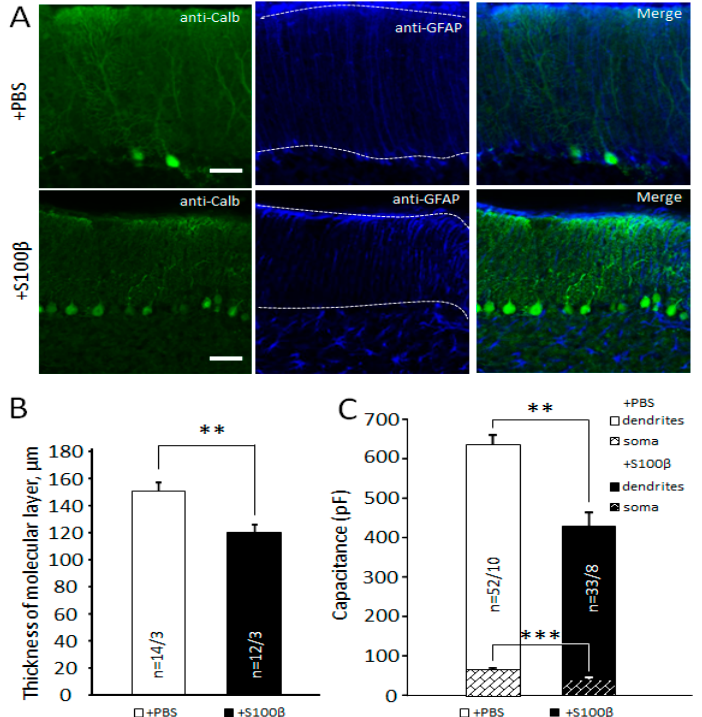
Figure 4. Alters the Purkinje cells’ (PCs’) morphology of mouse cerebellum. ( A ) Comparison of immunoreactivity to anti-calbindin (PCs’ marker), and anti-GFAP in injected areas with PBS (upper panel) and S100 β (lower panel). The molecular layer selected by white broken lines. Scale bar 50 µ m. ( B ) In comparison with PBS-injected areas, the molecular layer was significantly thinner (79.6%) in S100 β injected areas. ( C ) In comparison with PBS-injected areas, the capacitance of PCs’ dendrites and soma measured by voltage-clamp was significantly smaller in S100 β injected areas. ** p < 0.01, *** p < 0.001.